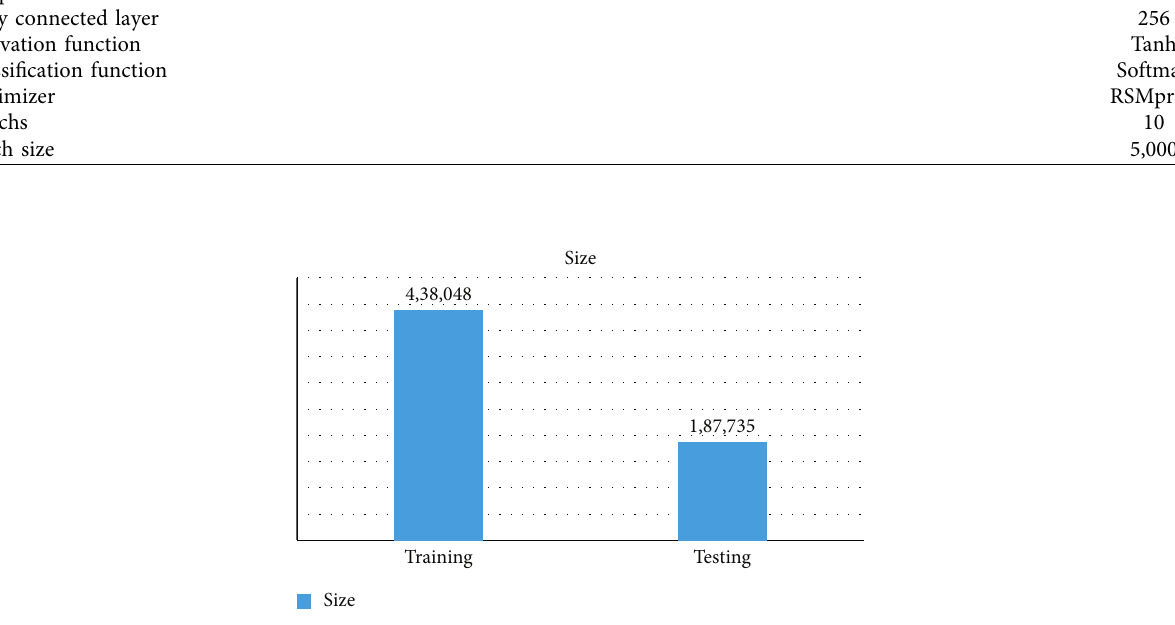
Figure 9: Size of sample for training and testing.